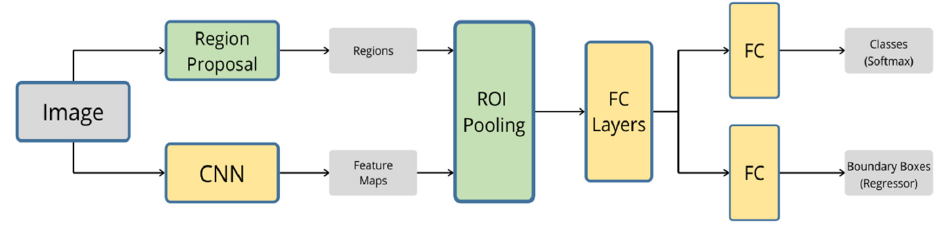
Figure 12. The architecture of fast R-CNN.